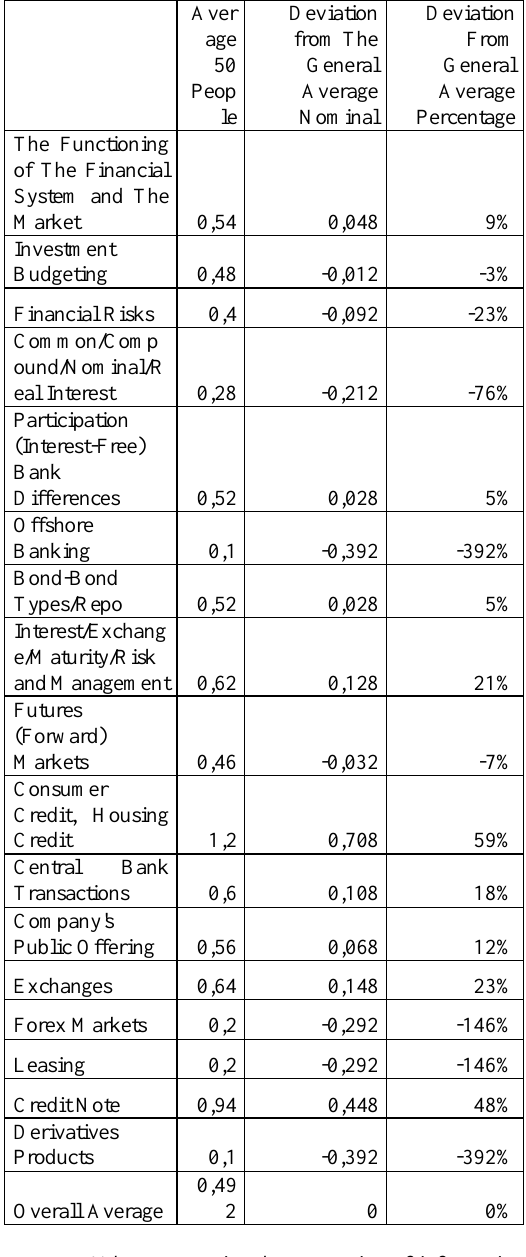
Table 5. Average Knowledge Level That Teachers